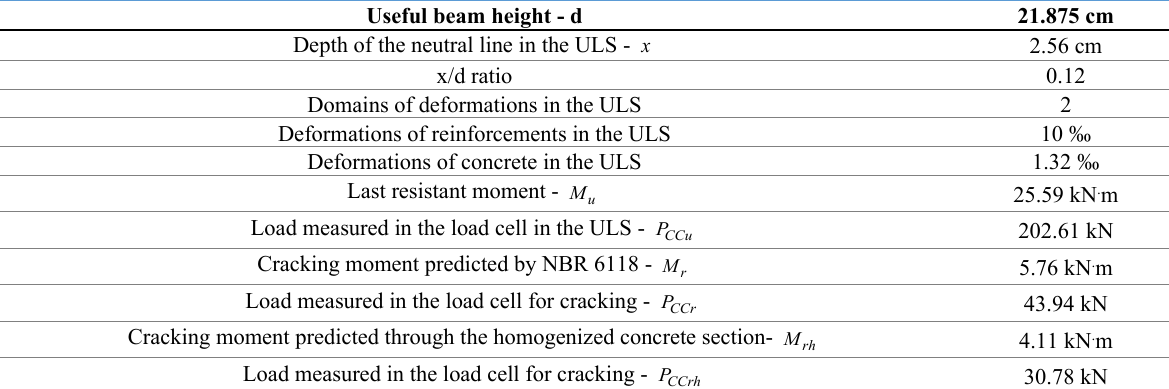
Table 2. Results of the theoretical efforts calculated according to the equations presented in section 2 Useful beam height - d 21.875 cm Depth of the neutral line in the ULS - x 2.56 cm x/d ratio 0.12 Domains of deformations in the ULS 2 Deformations of reinforcements in the ULS 10 ‰ Deformations of concrete in the ULS 1.32 ‰ Last resistant moment - u M 25.59 kN . m Load measured in the load cell in the ULS - CCu P 202.61 kN Cracking moment predicted by NBR 6118 - r M 5.76 kN . m Load measured in the load cell for cracking - CCr